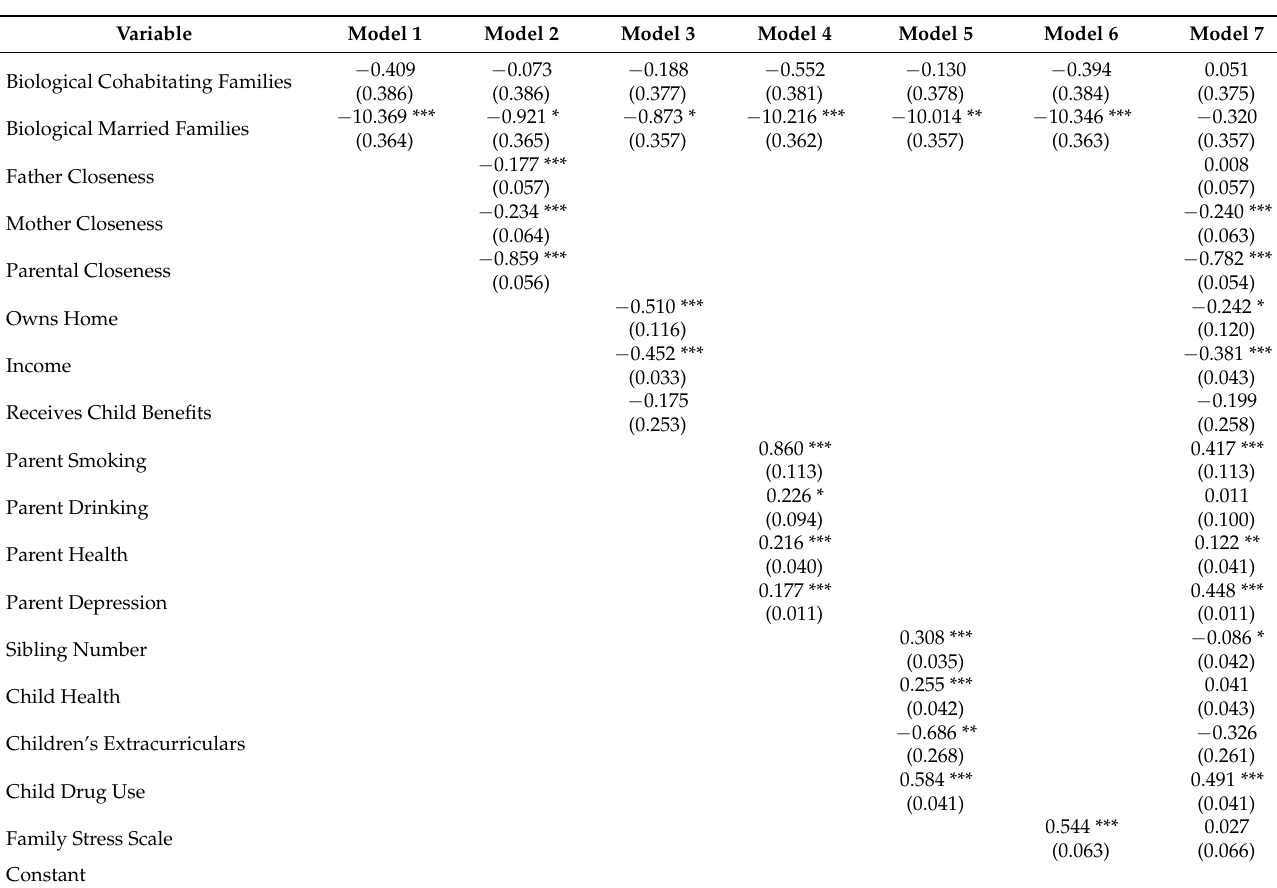
Table 4. Ordinary Least Squares Regression of Externalizing Behavior Problems on Family Structure (Model 1), Parental Closeness, (Model 2) Financial Resources (Model 3), Parental Health (Model 4), Child Health (Model 5), Family Stress (Model 6) and Full Model (Model 7). Stepmother families are the reference